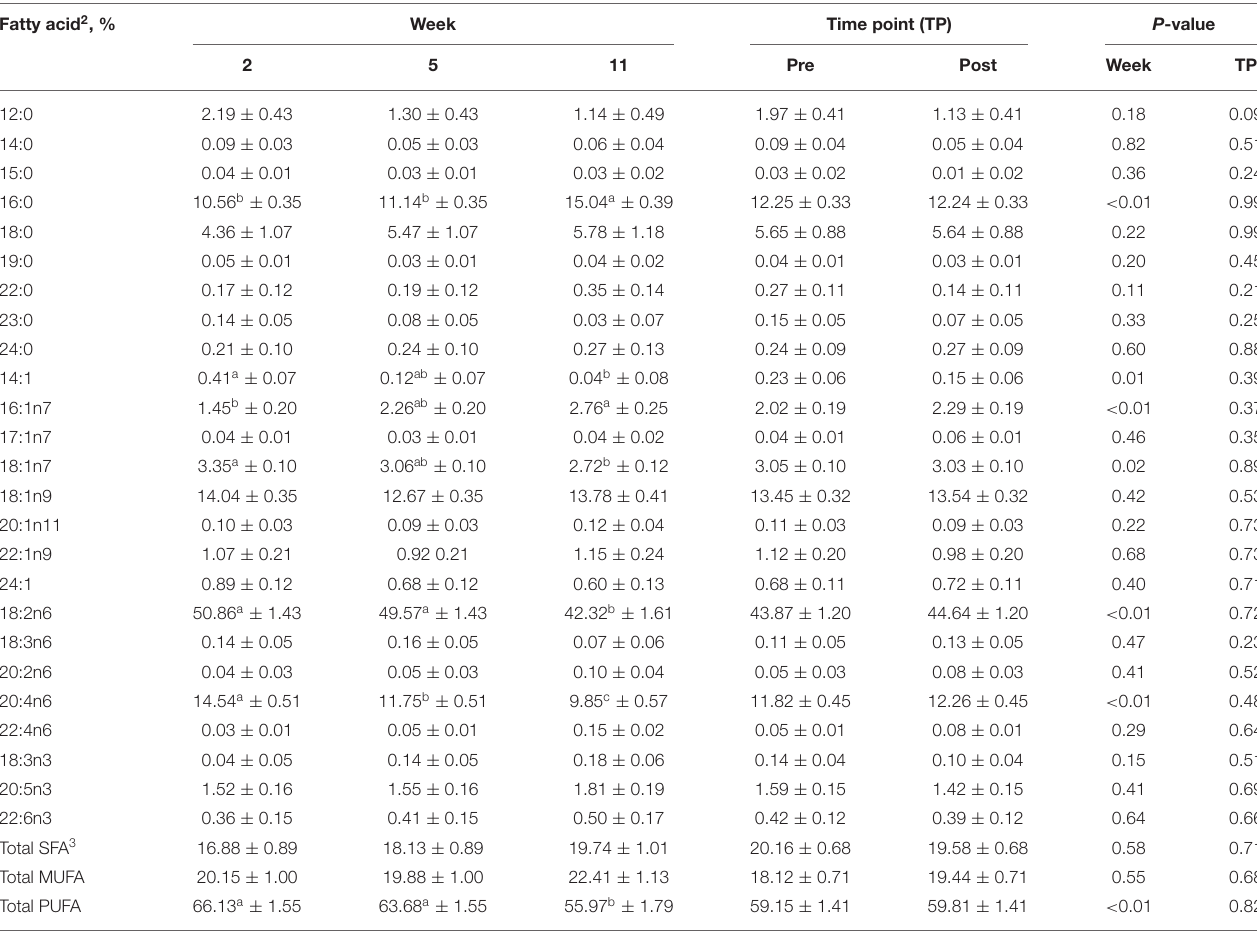
TABLE 2 | Mean fatty acid composition ( ± SE 1 ) and percent contribution of saturated fatty acids (SFA), monounsaturated fatty acids (MUFA), and polyunsaturated fatty acids (PUFA) for the cholesterol ester (CE) fraction identified in serum of all dogs at weeks 2, 5, and 11 (pooled across pre- and post-exercise sampling time points) and at the pre- and post-exercise sampling time points (pooled across weeks 2, 5, and 11). Fatty acid 2 ,